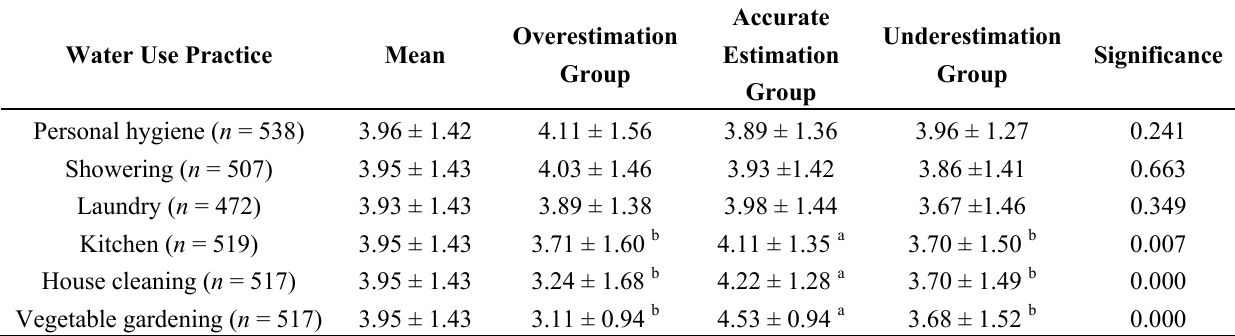
Table 5. Water conservation consciousness under different perception groups for each water use pattern (Mean ±